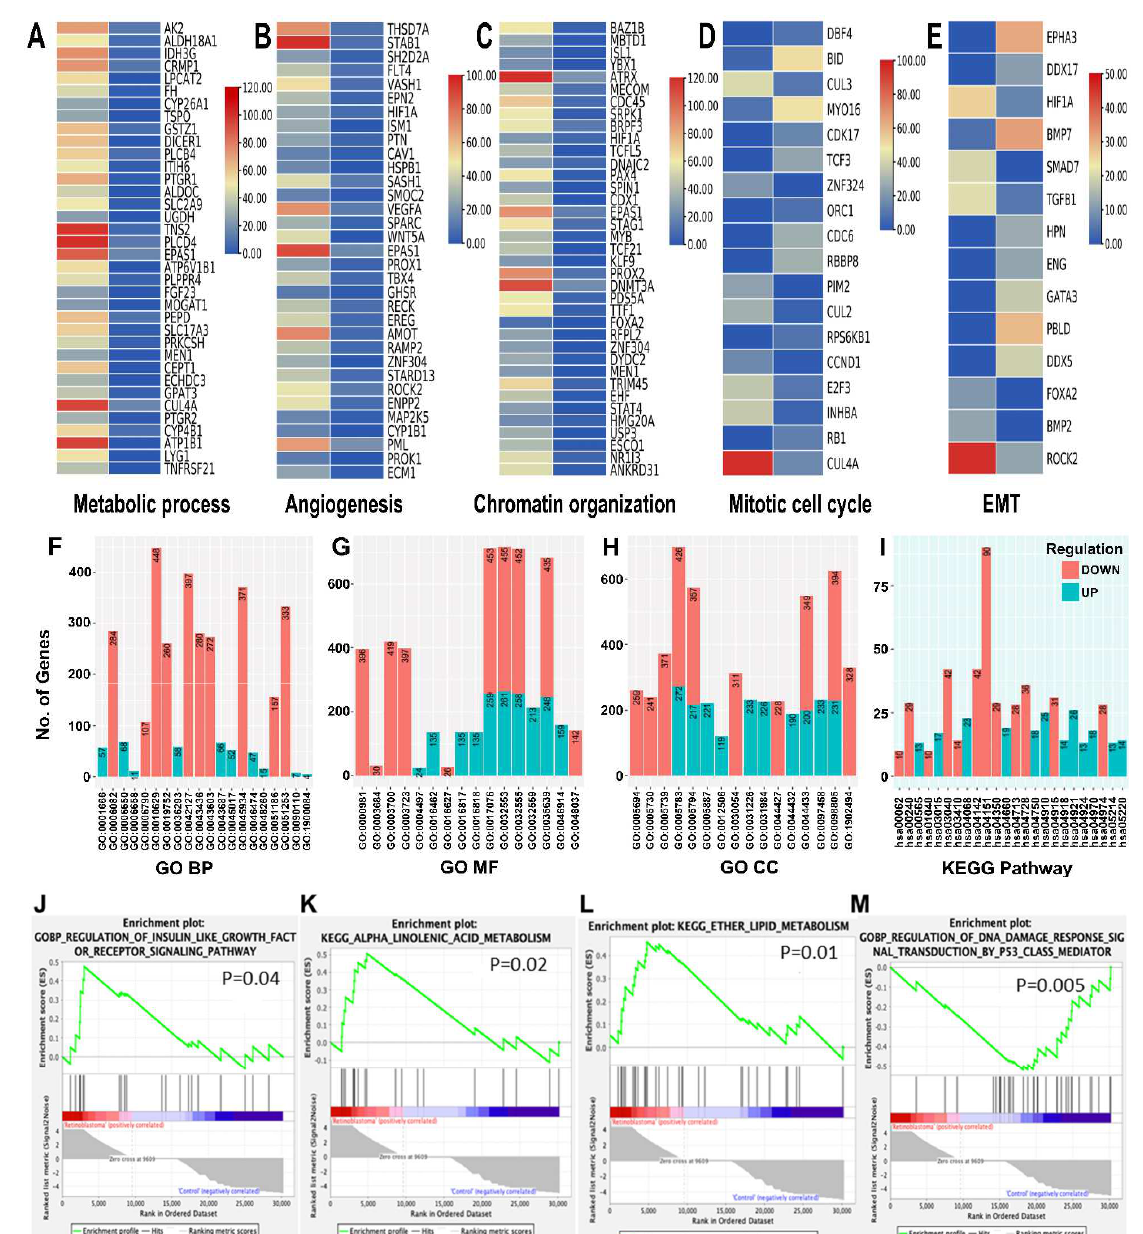
KW-0238: DNA-binding (FDR = 0.02).